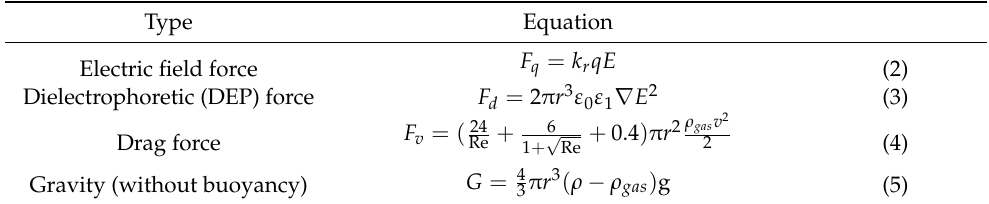
Figure 2. Force analysis diagram of particle. Table 1. Equations of force.